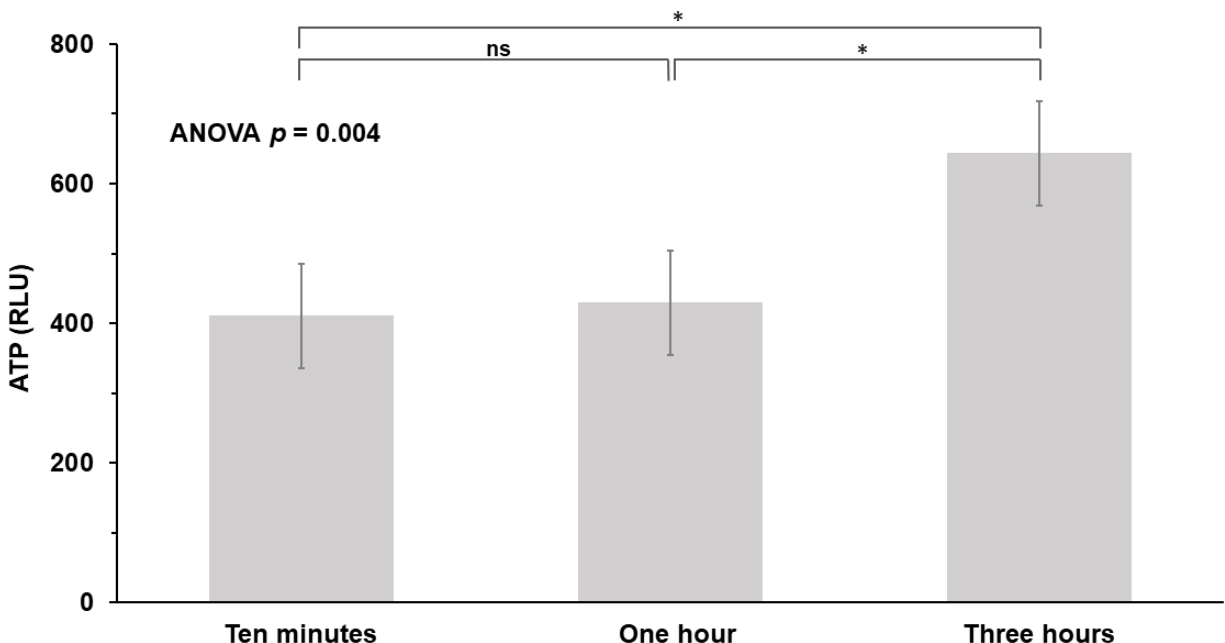
Figure 2. Values of ATP on different button locations at ( A ) one-hour intervals and ( B ) three-hour intervals. ATP, adenosine triphosphate; RLU, relative light unit; * p < 0.05, *** p < 0.001. Pooled ATP values from buttons at different time intervals, including ten minutes (410.8 ± 410.3 RLU), one hour (429.7 ± 351.1 RLU), and three hours (644.0 ± 363.4 RLU), were significantly different ( p = 0.004, ANOVA) (Figure 3).